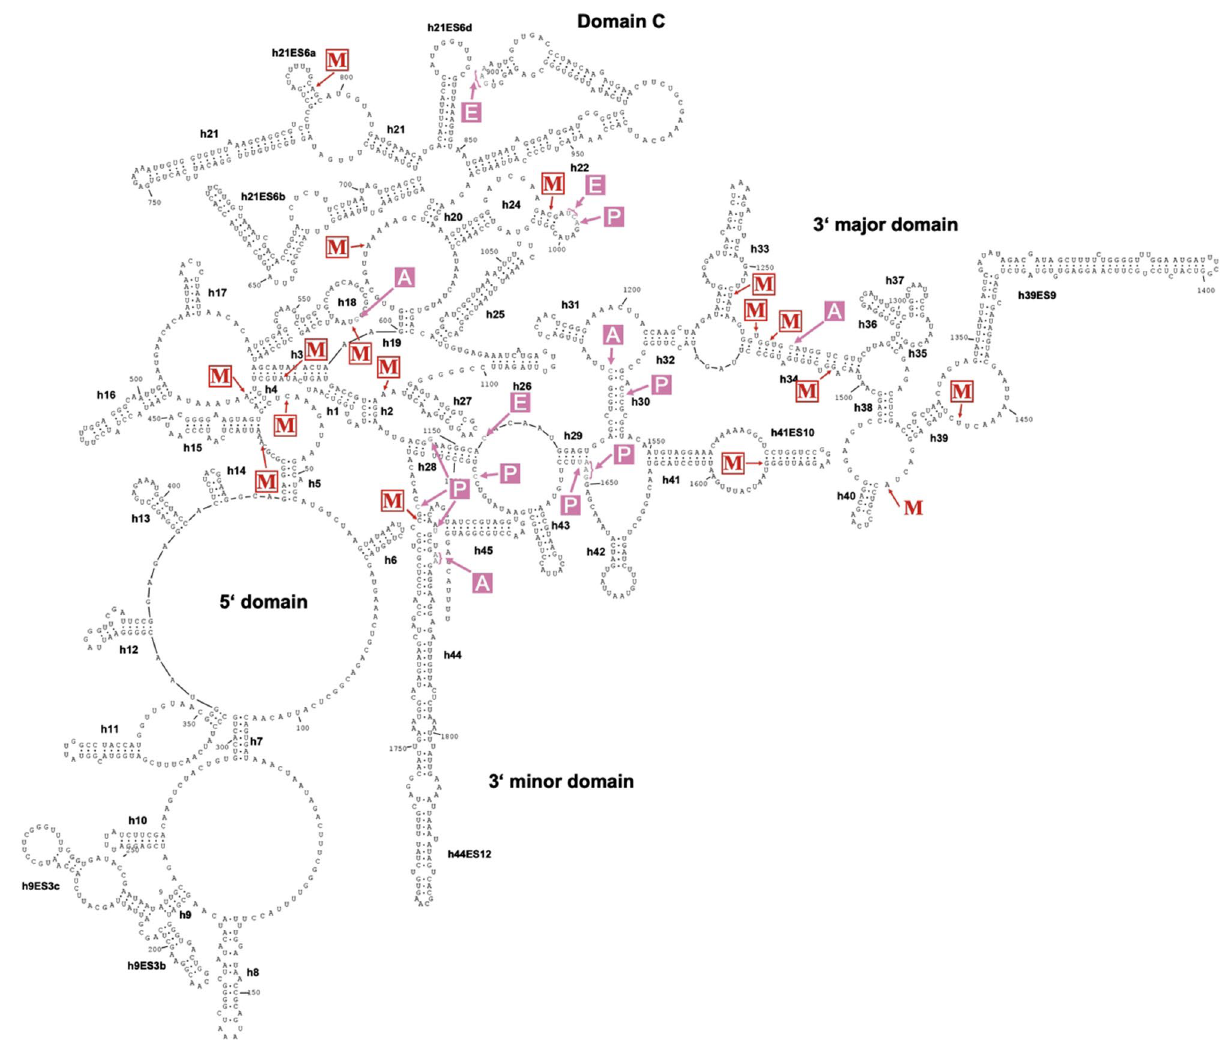
Figure 3. Secondary structure of the 17S rRNA of D. discoideum with 2 ′ - O -Me sites. The secondary structure of the 17S rRNA was inferred by homology and drawn using RNAviz (v. 2.0.3). The 2 ′ - O -methylated nucleotides as identified by RiboMeth-seq are marked with an arrow and ‘M’ (red). Nucleotides located in the A, P, and E sites of the ribosome are indicated in pink. Helices (hx) are named to convention and expansion segments (ESx) are labeled with x: natural